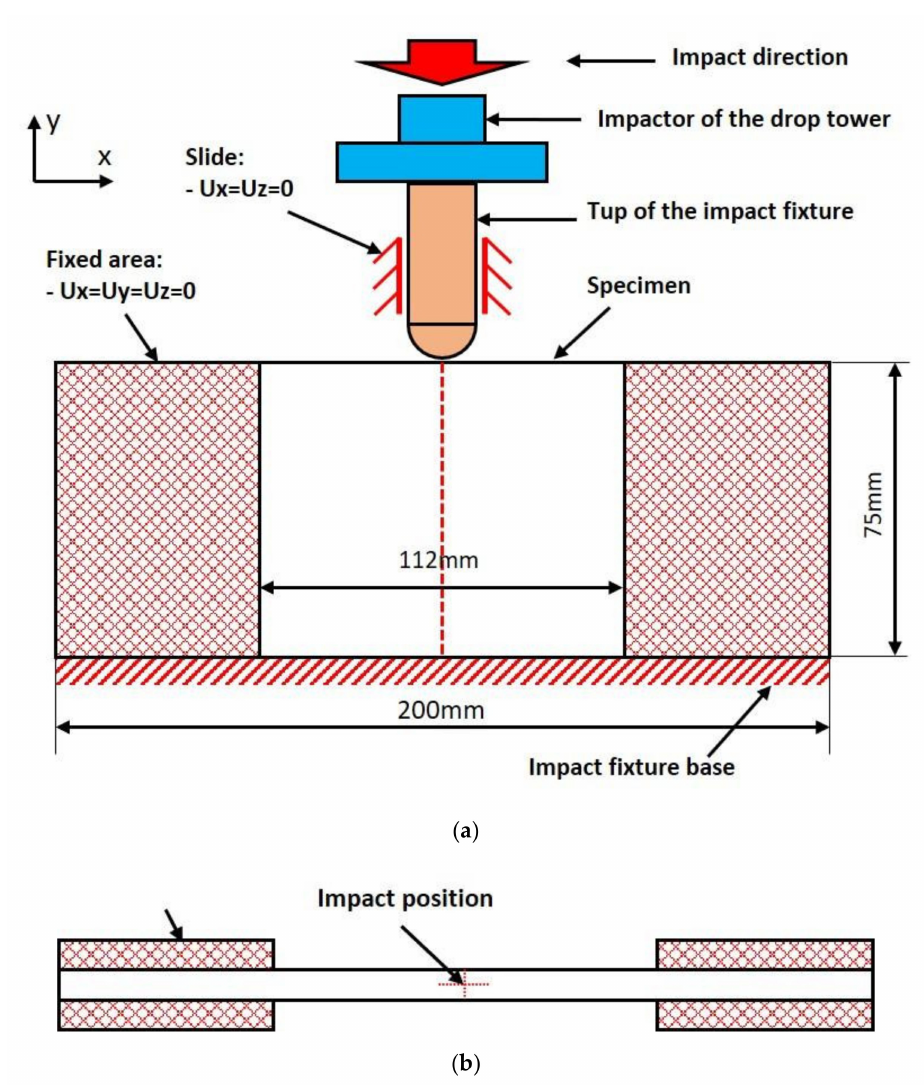
Figure 2. The setup of the impact tests. ( a ) Font view; ( b ) top view.